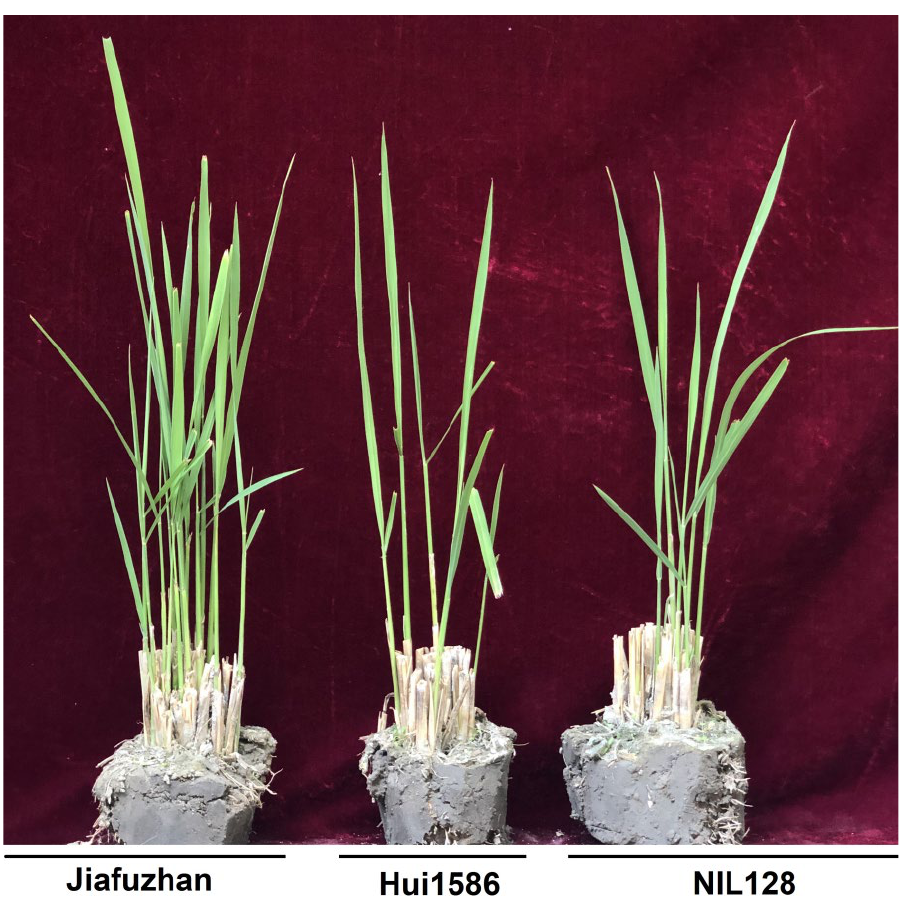
Figure 1. Ratooning ability comparison of Jiafuzhan, Hui1586, and NIL128. The phenotypes of Jiafuzhan, Hui1586, and NIL128 during the ratooning period are shown. Table 1. Comparison of the main agronomical traits of Jiafuzhan, NIL128, and the qRA2KO knockout mutant lines.